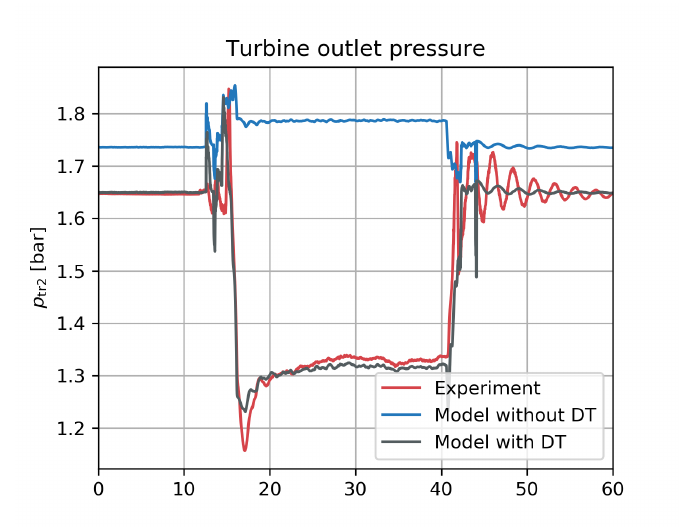
Figure 8. Comparison of the turbine outlet pressure from the simple model simulations with different draft tube (DT) settings and experimental measurements.